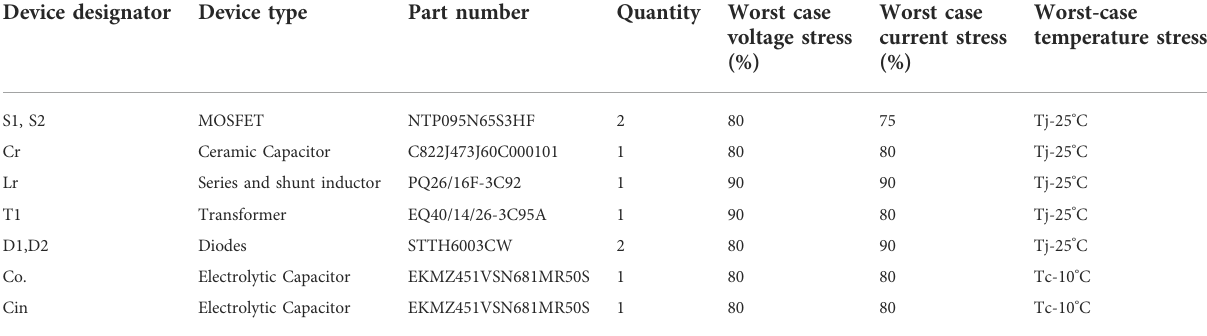
TABLE 2 Component list of LLC converter with worst-case component stress values (IPC-9592, 2008). Device